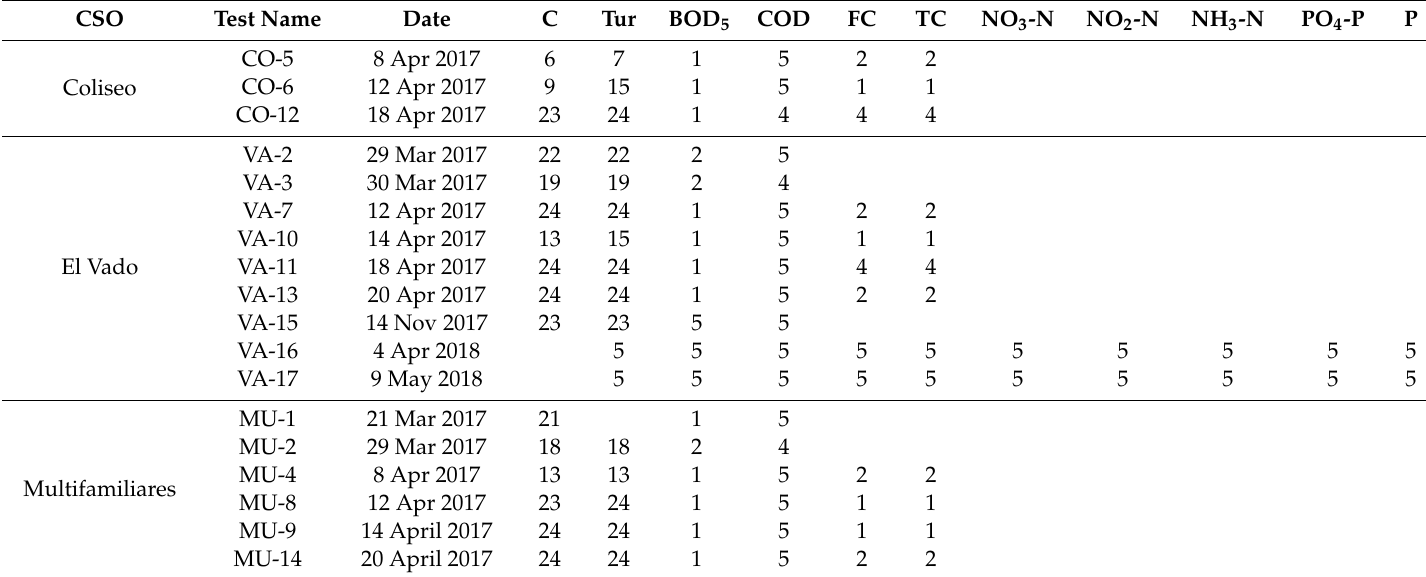
Multifamiliares